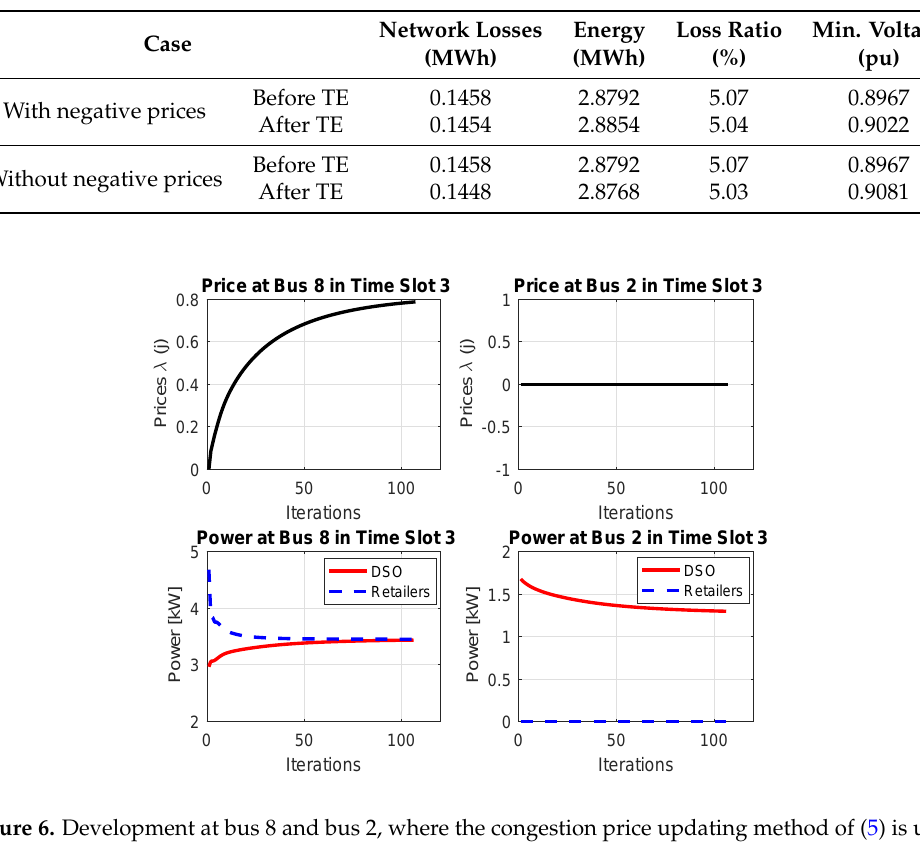
Figure 6. Development at bus 8 and bus 2, where the congestion price updating method of (5) is